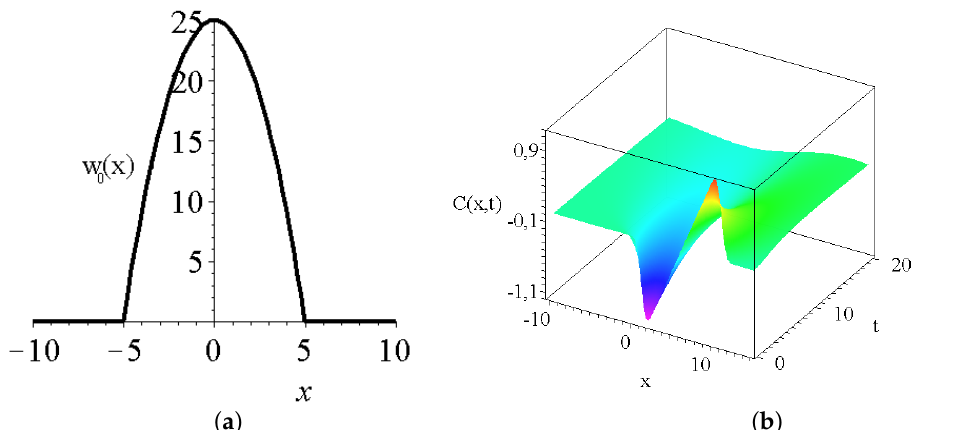
Figure 3. ( a ) The initial condition of Equation (15), ( b ) the full solution C ( x , t ) of Equation